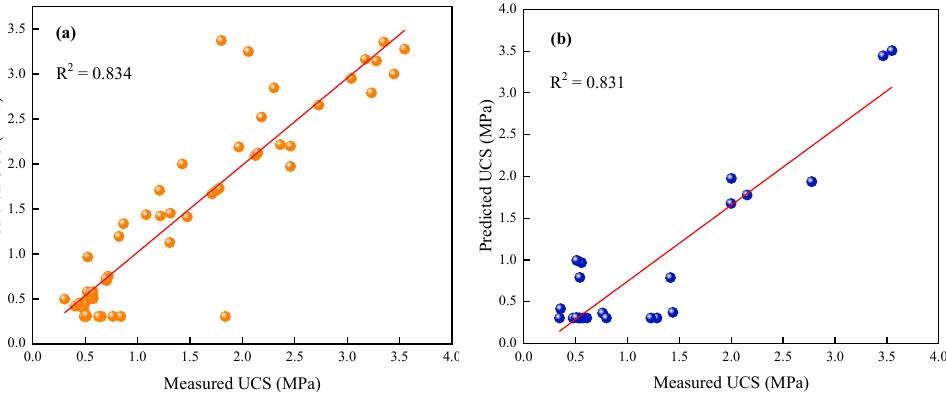
Figure 11. ANN model M2 results for UCS plotted against the measured data for the ( a ) training and ( b ) testing data.